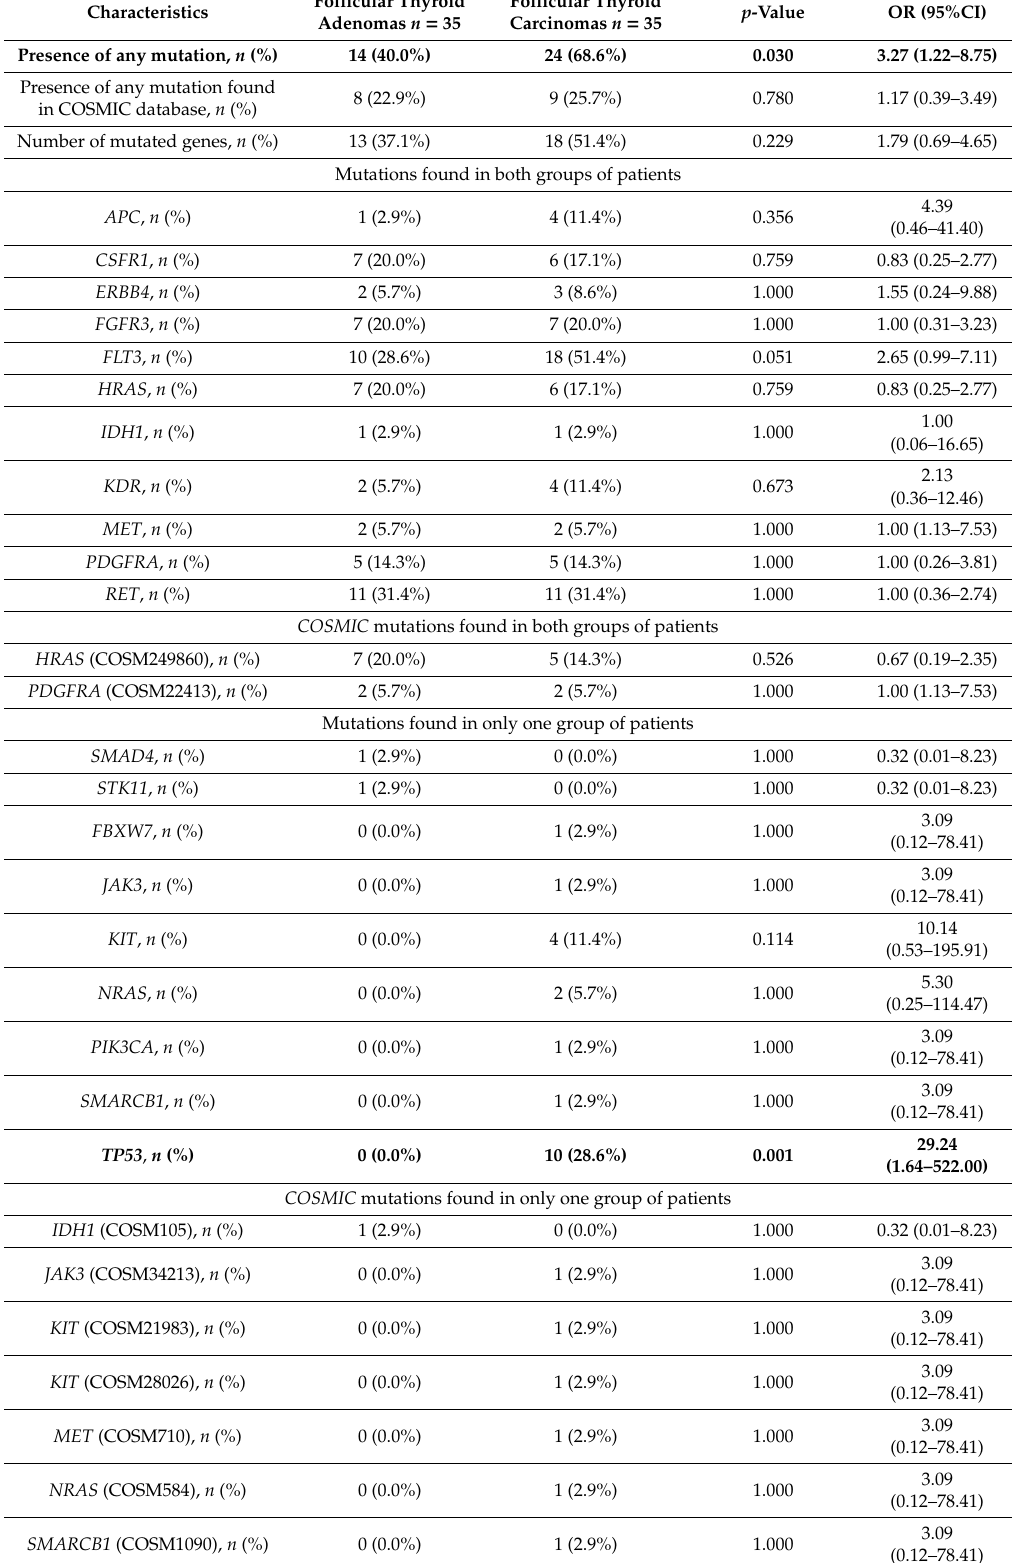
Table 1. Patients’ mutational status according to histopathological